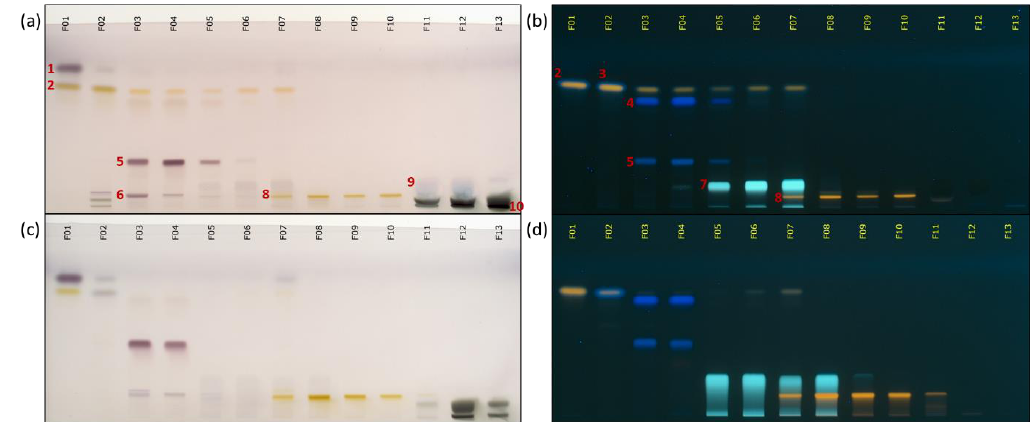
Figure 3. Recapitulative high performance (HP)TLC plates of the CPC fractionations. ( a , b ) refer to glycerin model mixture; ( c , d ) refer to dry model mixture. Vanillin / sulphuric acid reagent was used for plates ( a , c ) while ( b , d ) were revealed by the Neu reagent. According to the high-performance (HP)TLC plates of the analytical standards available in Figure S1, several standards have been assigned: 1: Linoleic acid; 2: Quercetin; 3: Ferulic acid, vanillin; 4: Gallic acid; 5: Polydatin; 6: Glycyrrhizin; 7: Chlorogenic acid; 8: Rutin; 9: Glycerin; 10: D-fructose, D-glucose, and sucrose.